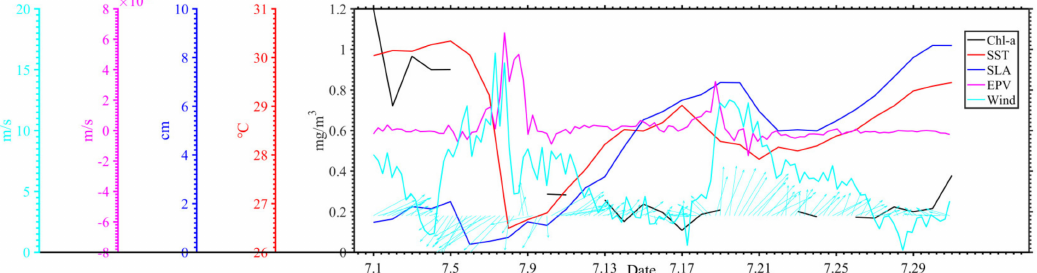
Figure 15. Time series of Chl- a concentration, sea surface temperature, sea level anomaly, Ekman pumping velocity, and wind speed (vector) in the continental shelf region where the typhoon